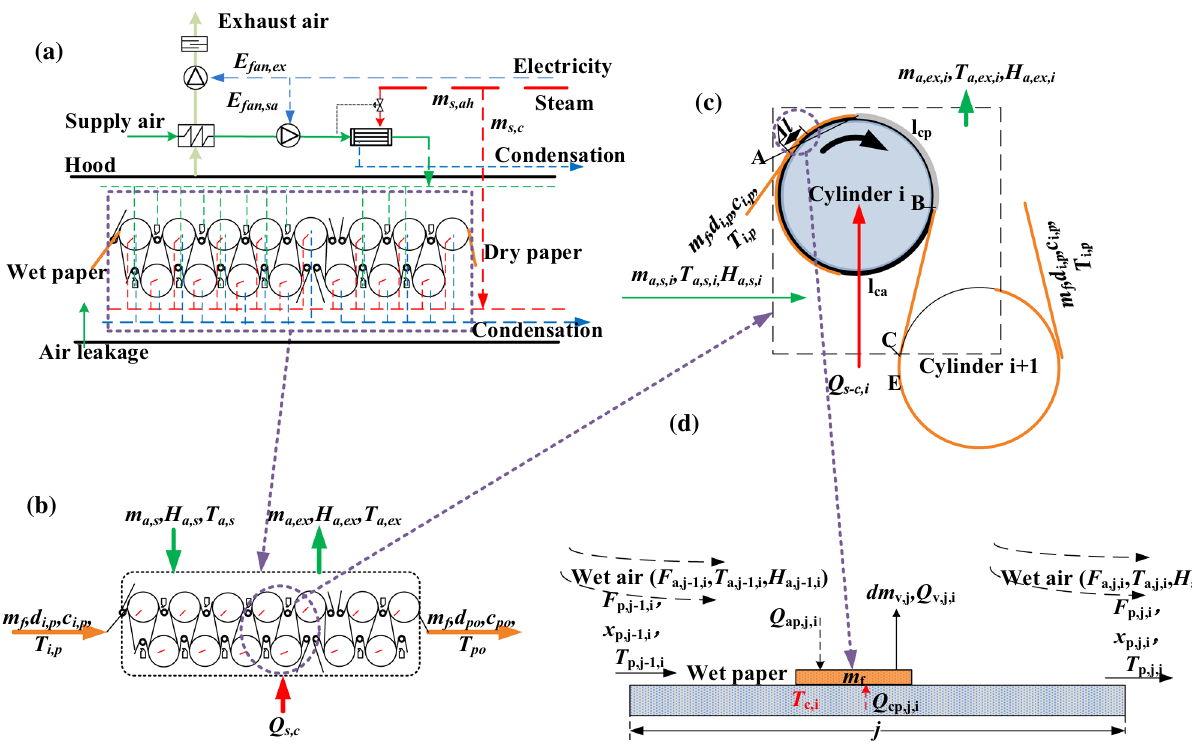
Fig. 3 Modeling of paper moisture evaporation in multi-cylinders dryer